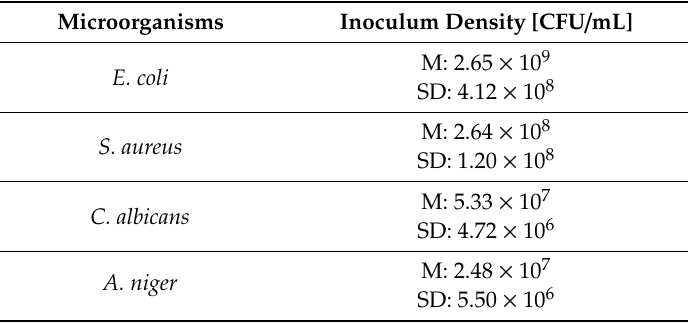
Table 3. Density of inoculating solutions of